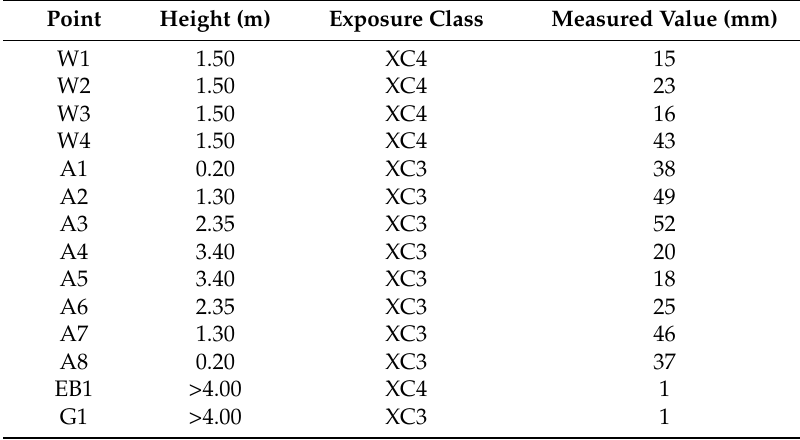
Table 12. Results of measuring carbonation depth x c (46) in the Weikendorf bridge, for wings (W), abutments (A), edge beam (EB) and girder (G).